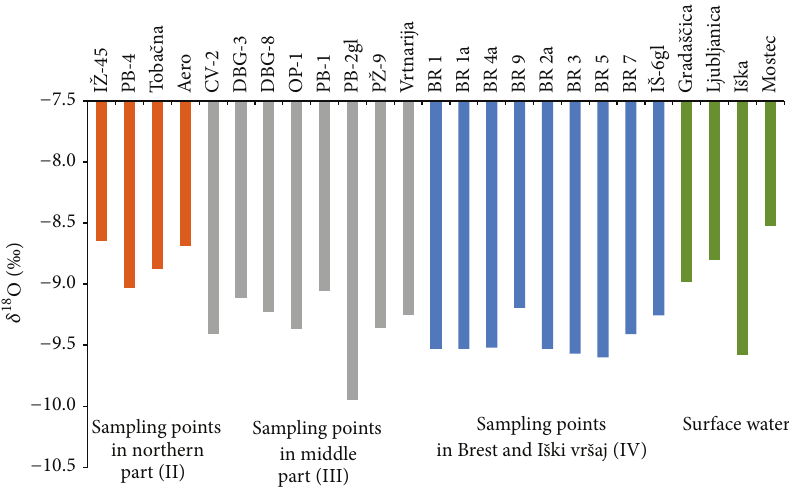
Figure 7: Isotopic composition of oxygen in groundwater and surface waters of Ljubljansko Barje aquifer.